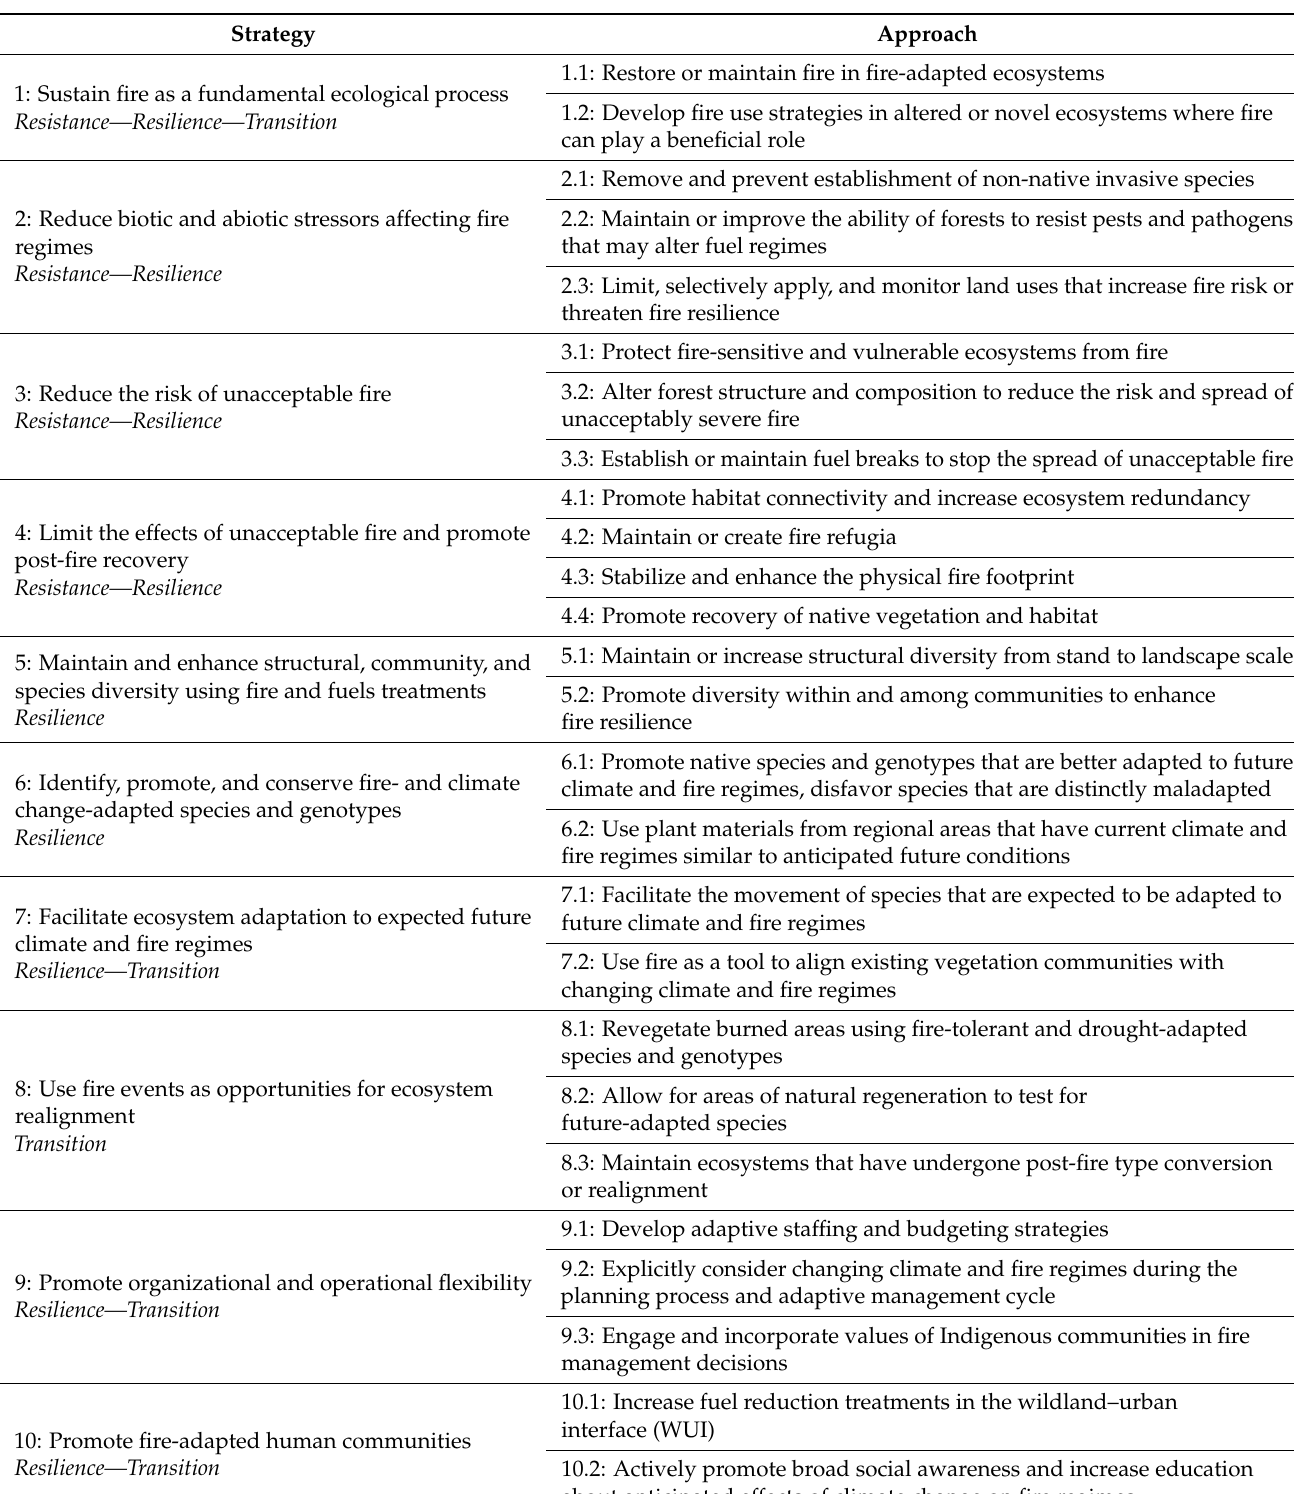
Table 1. Strategies and approaches for climate and fire adaptation. Strategies are “tagged” with applicable adaptation concepts (resistance, resilience, and/or transition) in italics underneath the title. Example tactics for each approach are listed in Appendix